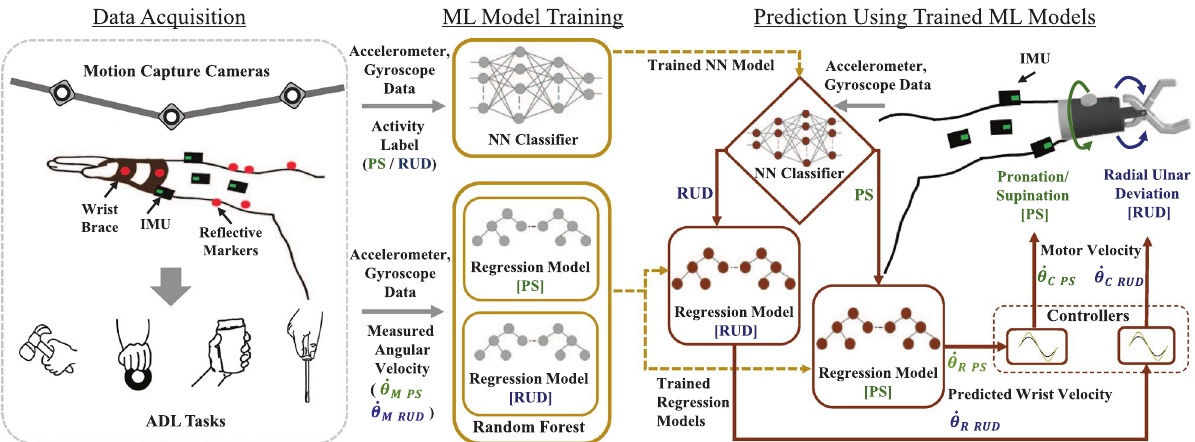
Figure 1. Overview of the proposed framework for modelling multi-DoF wrist control. Data collected from activities of daily living is used to train neural network classifier and regression models of radial/ulnar deviation (RUD) & pronation/supination (PS). Regression models and the control modules predict the angular velocity for controlling motors in a robotic prosthetic wrist. for RUD and PS computed using a motion capture system. RUD and PS predicted by regression models. modules for RUD and